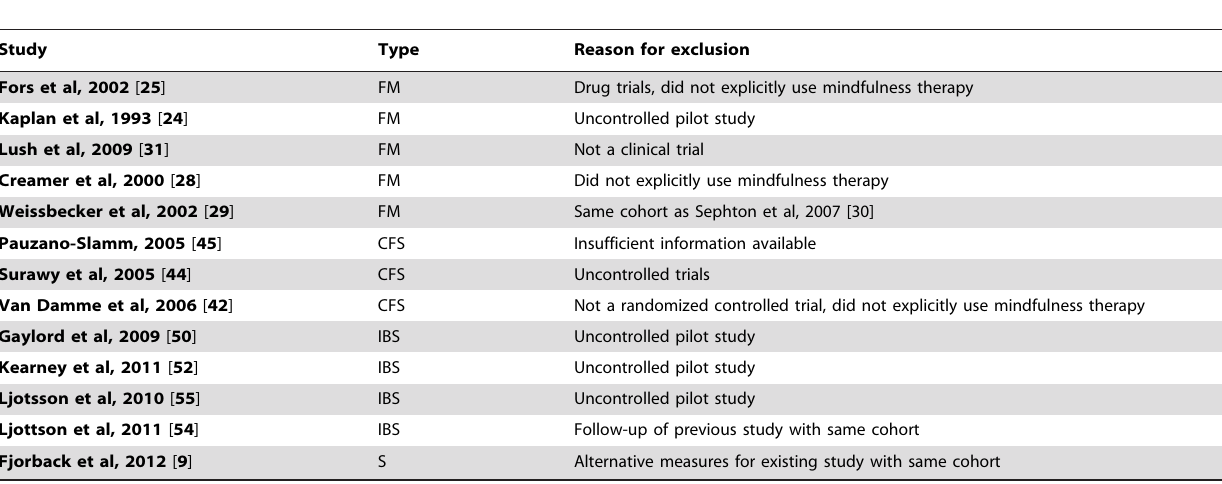
Table 2. Characteristics of studies excluded from meta-analysis yet included in systematic review.